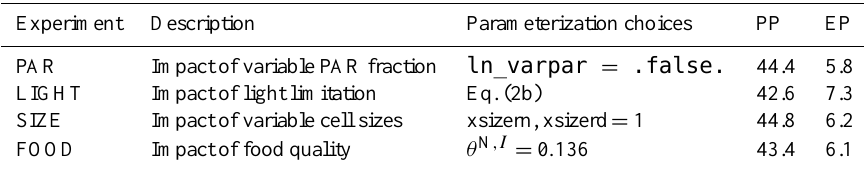
Table 7. Sensitivity experiments performed with PISCES to evaluate the impact of specific parameterizations. Primary production (PP) and export production at 150m (EP) are in GtCyr − 1